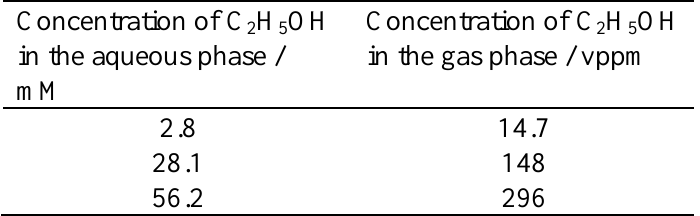
Table 2. Equilibrium gas phase concentrations above an aqueous ethanol solution at 25 °C according to the Henry’s law constant given by Snider et al. [21] and equation (1) given by Sander [20].